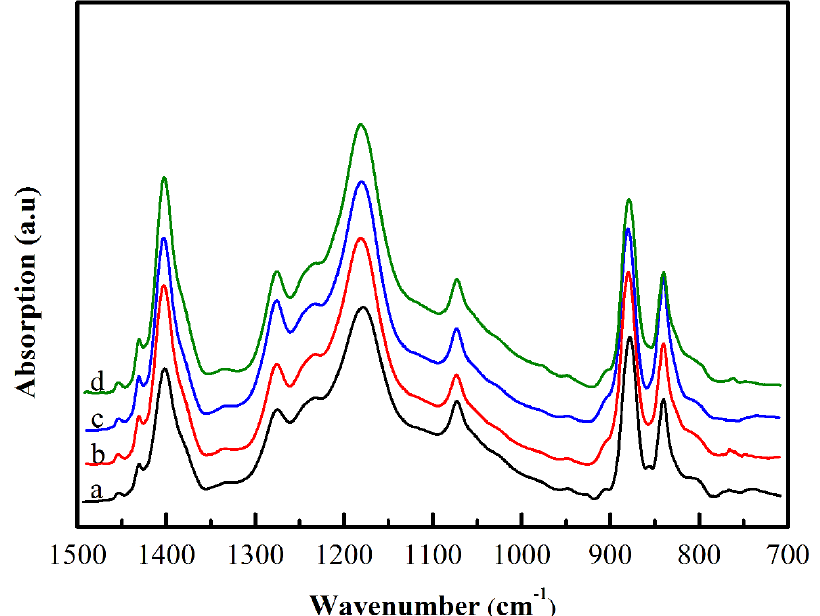
Figure 3. ATR-FTIR analysis of electrospun nanofiber webs. The curves in this graph represent ( a ) 0. ( b ) 0.5 wt%. ( c ) 1.5 wt%. ( d ) 3.0 wt% Ag NWs doped PVDF nanofiber web,